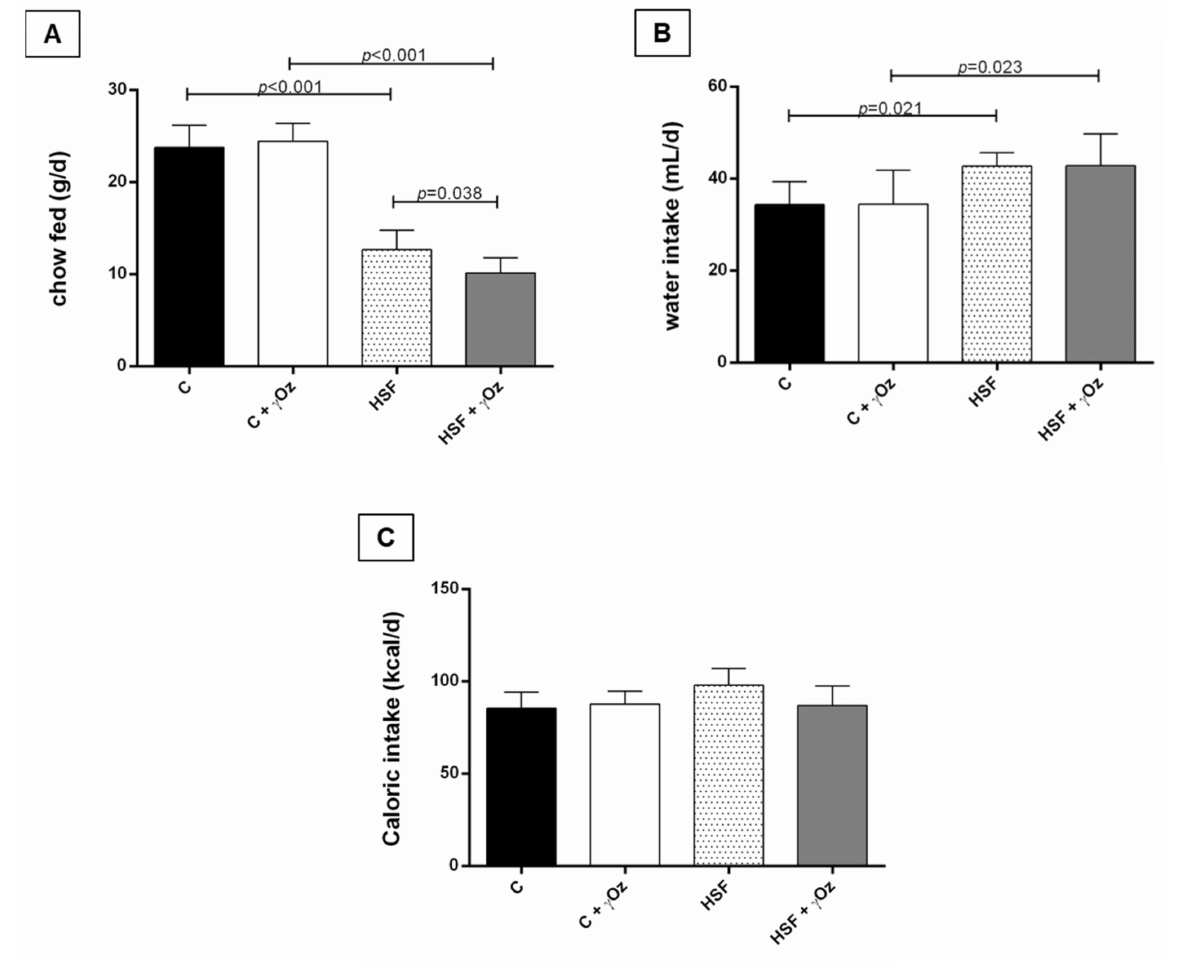
Figure 2. Nutritional intake. ( A ) Chow fed (g/d); ( B ) Water intake (mL/d); ( C ) Caloric intake (kcal/d). Comparison by two-way ANOVA followed by Tukey test. p < 0.05 as